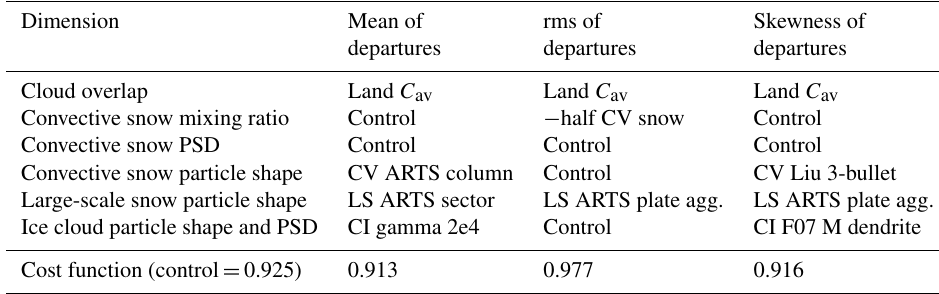
Table 5. Results of parameter search using alternative cost functions. Dimension Mean of rms of Skewness of departures departures departures Cloud overlap Land C av Land C av Land C av Convective snow mixing ratio Control − half CV snow Control Convective snow PSD Control Control Control Convective snow particle shape CV ARTS column Control CV Liu 3-bullet Large-scale snow particle